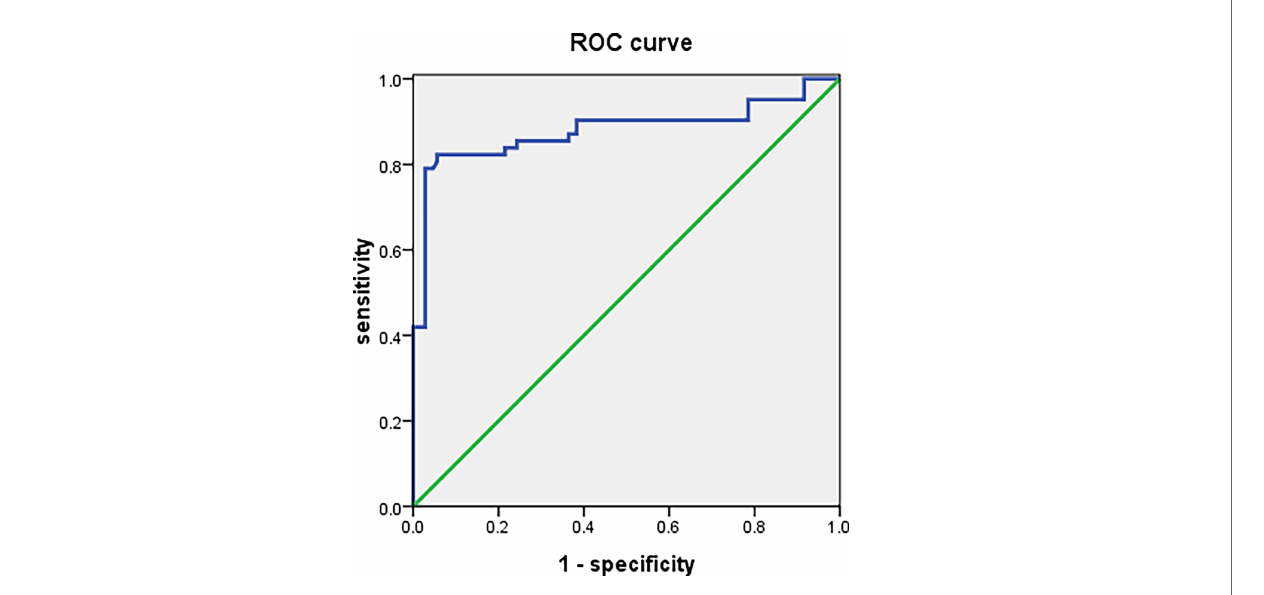
FIGURE 6 | ROC curve analysis for sporadic lupus patients and healthy